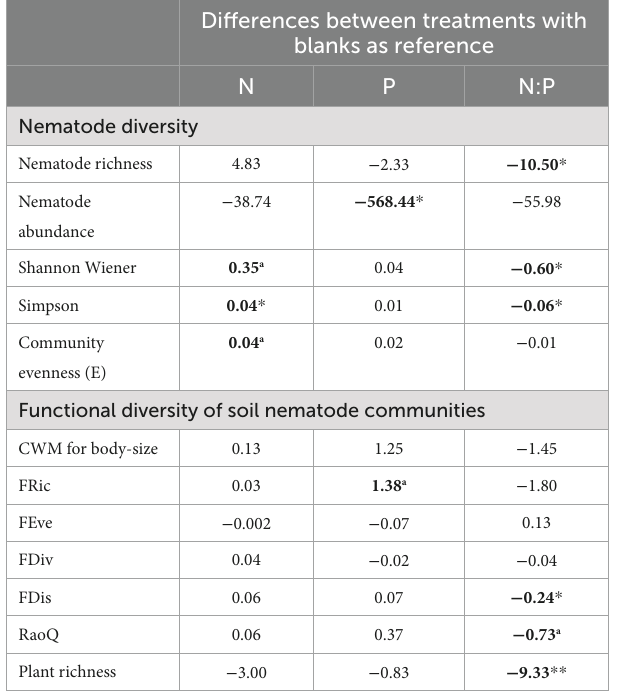
TABLE 2 Effect of N and P fertilizer addition and their interaction on subsurface soil environmental factors and functional attributes of the root